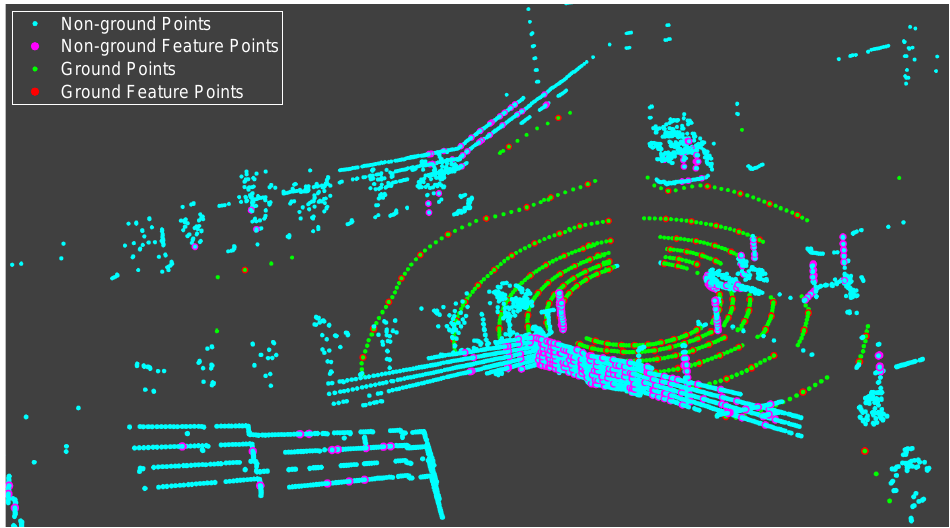
Figure 4. The feature points in typical road environment.